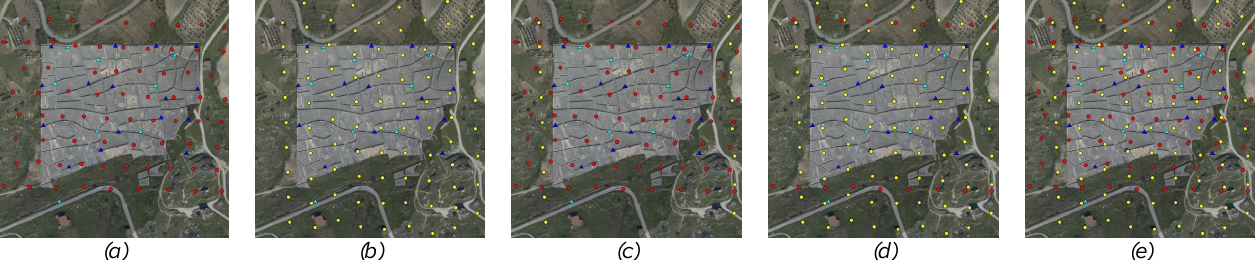
Figure 7. Different blocks configurations used for the analysis of the “Cretto of Gibellina”: East-West Block (a) ; North-South Block (b) ; East-West Block including two flight strips cross block (c) ; North- South block including two flight strips cross block (d) ; Both East-West and North-South Blocks (e) ; in blue the GCPs and in cyan the